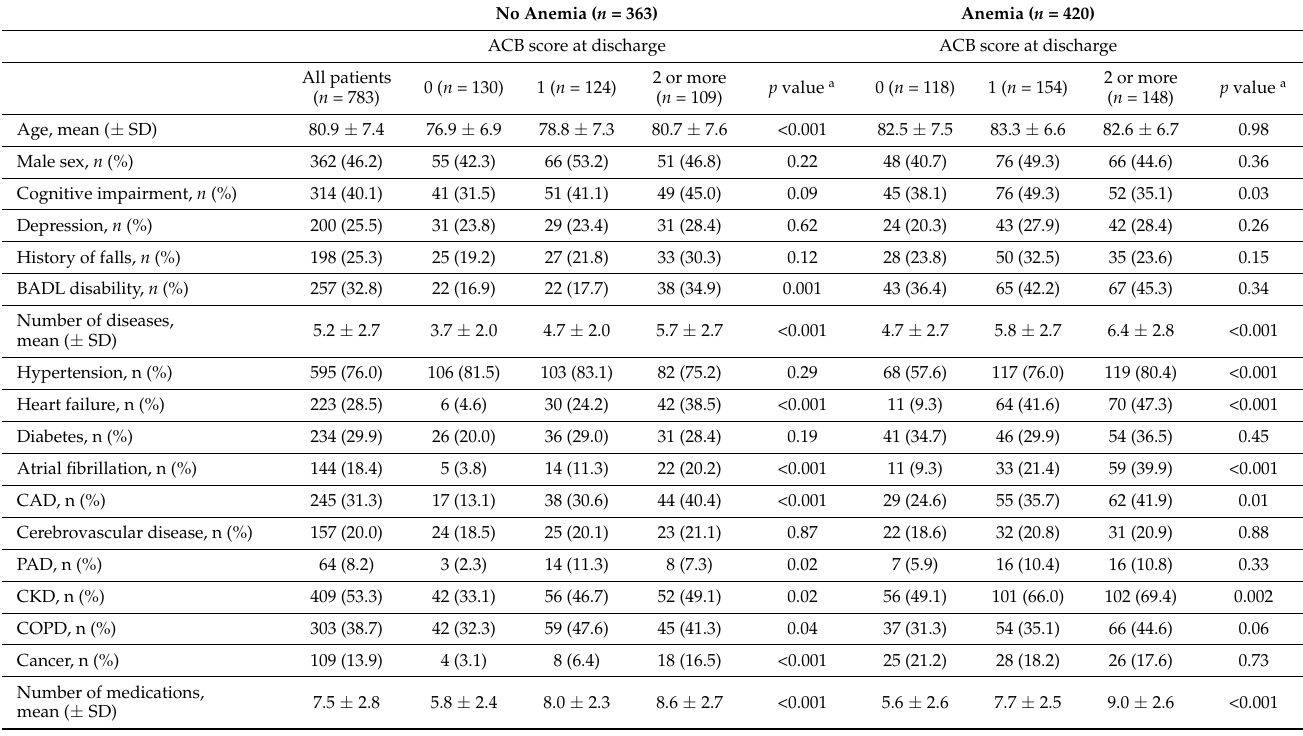
Table 1. Demographic and clinical characteristics of patients stratified by anemia and ACB score at discharge.